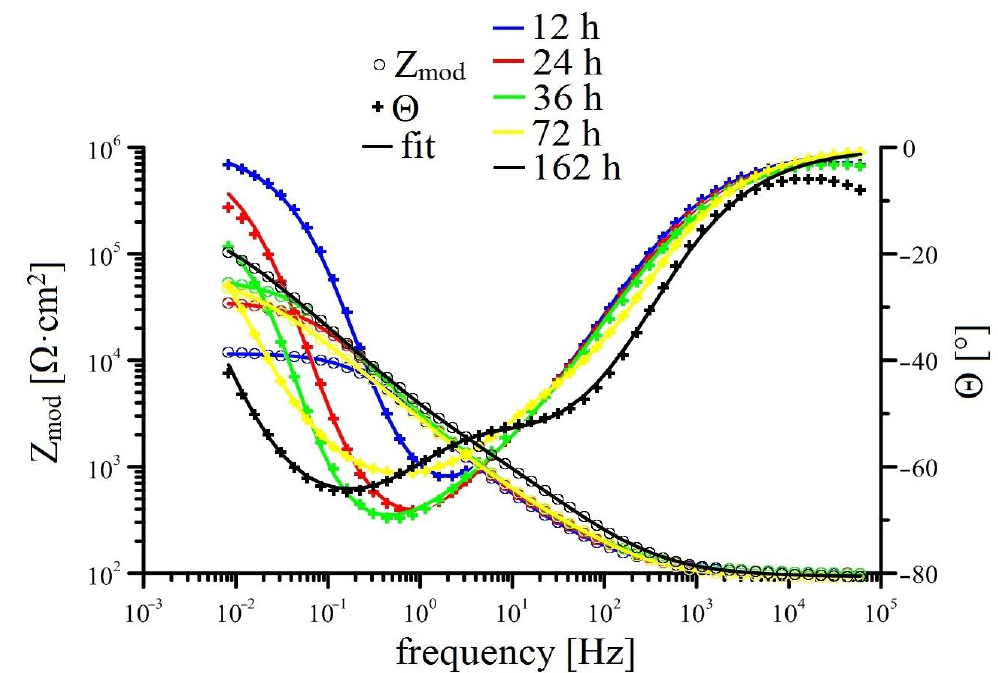
Figure 11. Time-dependent impedance spectra for Mn (3) solution (Bode plot: log Zmod vs. log frequency and phase angle vs. log frequency).